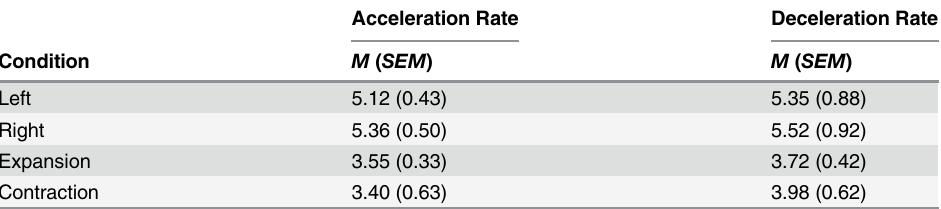
Table 1. Mean Absolute Value 75% Correct Acceleration and Deceleration Detection Threshold Rates (deg/s 2